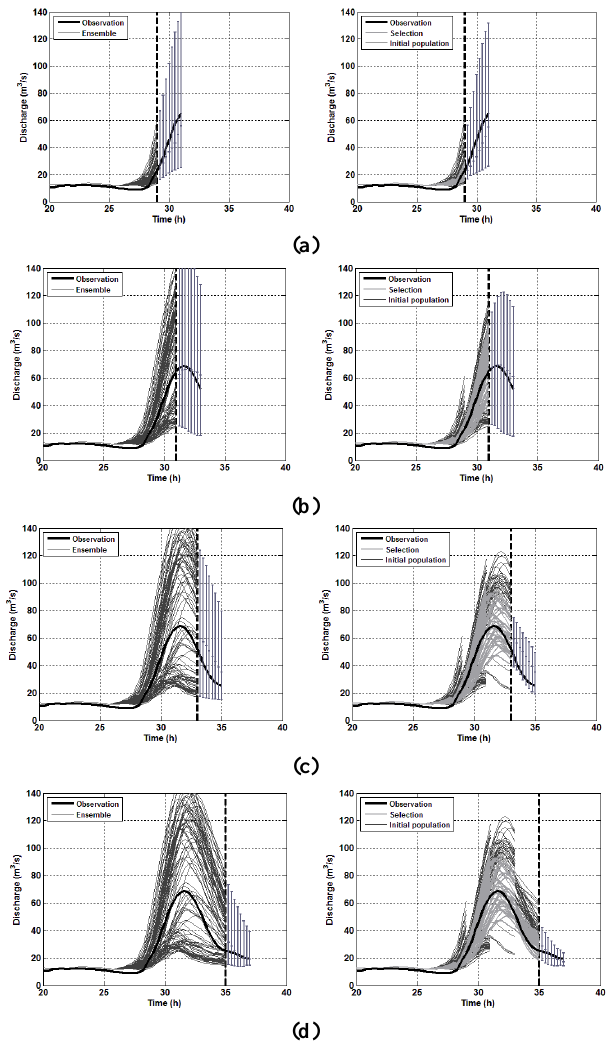
Fig. 5. Results of the forecast models for the April 2003 flood event. Figure 5. Results of the forecast models for the April 2003 flood event. The vertical dashed 4 The vertical dashed line is the current time step. Forecasts are ex- line is the current time step. Forecasts are expressed by the median and the prediction limits 5 pressed by the median and the prediction limits for a confidence for a confidence level of 5%. The first column shows the results of the forecast model without 6 level of 5%. The first column shows the results of the forecast data assimilation and the second column the forecast model with data assimilation. The rows 7 model without data assimilation and the second column the forecast show forecasts by current time step: a) t=29 hours; b) t=31 hours; c) t=33 hours; c) t=35 8 model with data assimilation. The rows show forecasts by current time step: (a) t = 29h; (b) t = 31h; (c) t = 33h; (d) t = 35h.